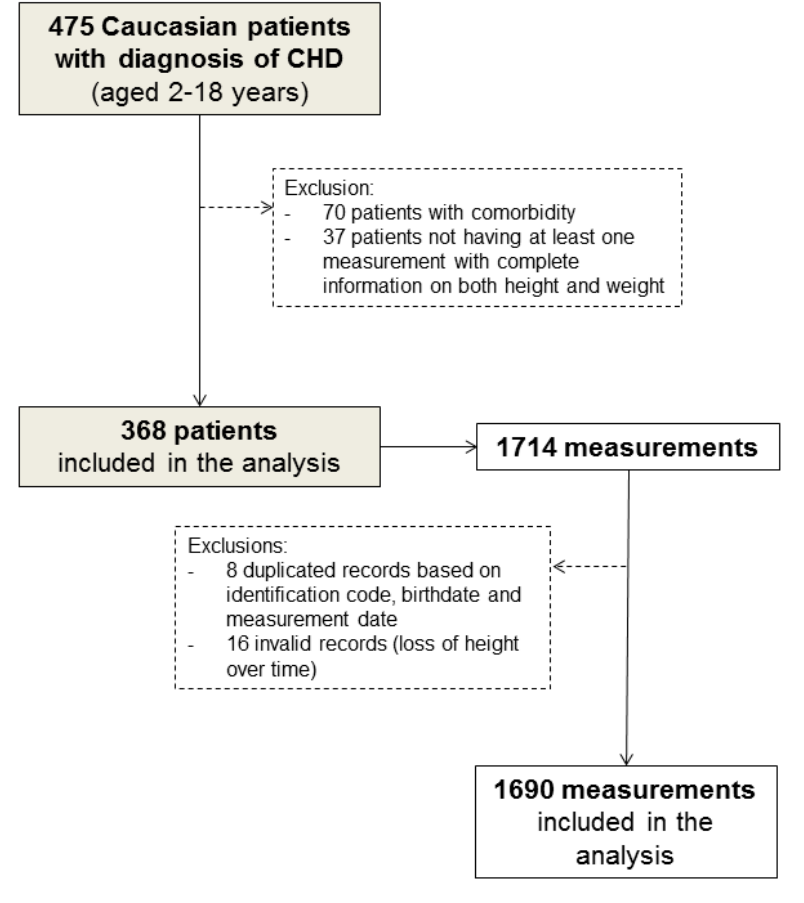
Figure 1. Flow chart of patient selection.